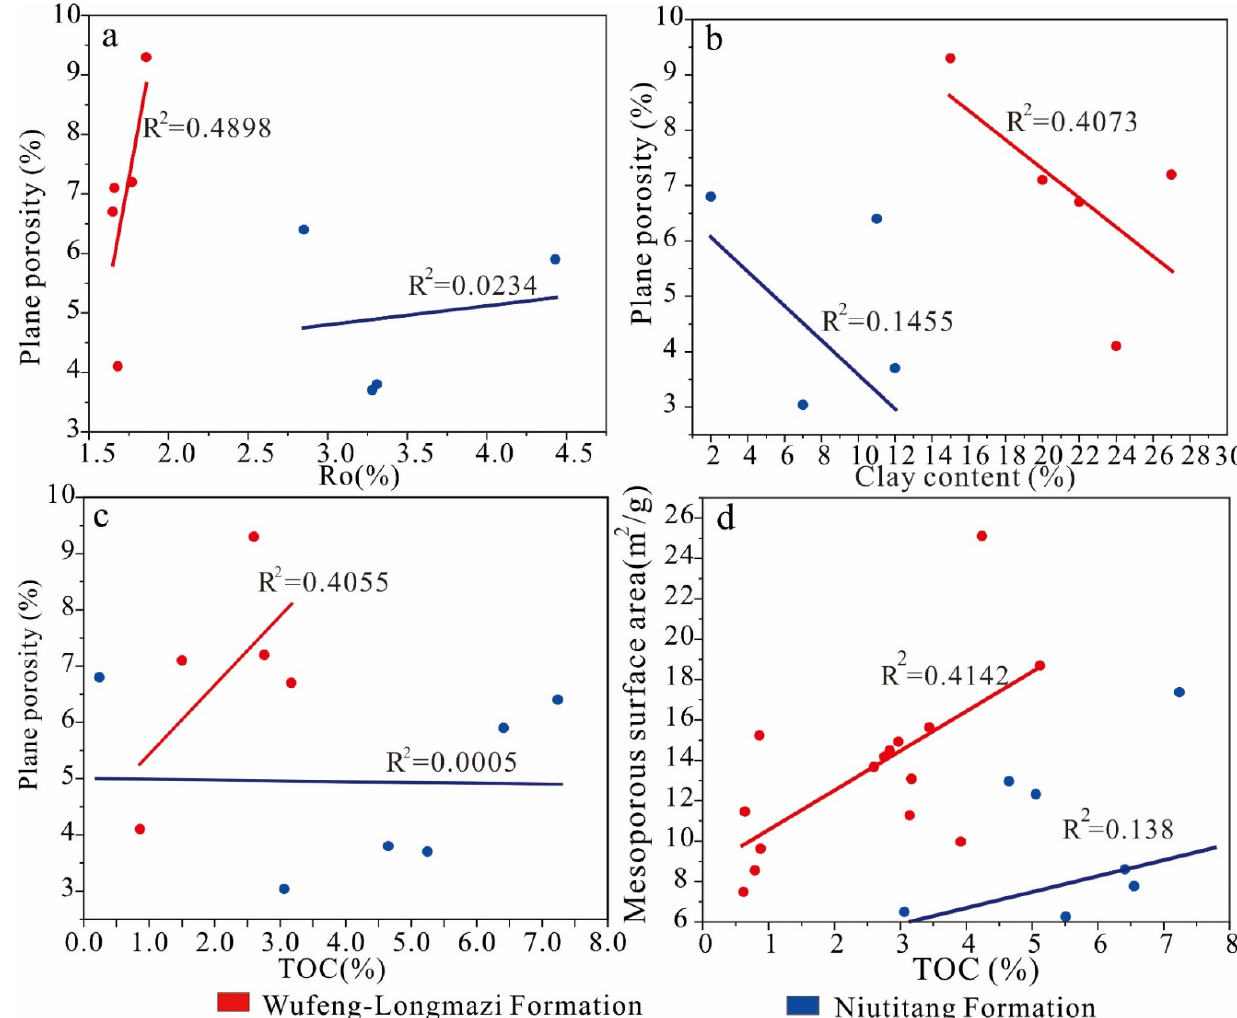
Figure 12. Correlation between Ro, clay content, TOC, and pore structure parameters. ( a ) Correlation map between Ro and Plane porosity of Wufeng-Longmaxi and Niutitang Formations; ( b ) Correlation map between Clay content and Plane porosity of Wufeng-Longmaxi and Niutitang Formations; ( c ) Correlation map between TOC and Plane porosity of Wufeng-Longmaxi and Niutitang Formations; ( d ) Correlation map between TOC and Mesoporous surface area of Wufeng-Longmaxi and Niutitang Formations.